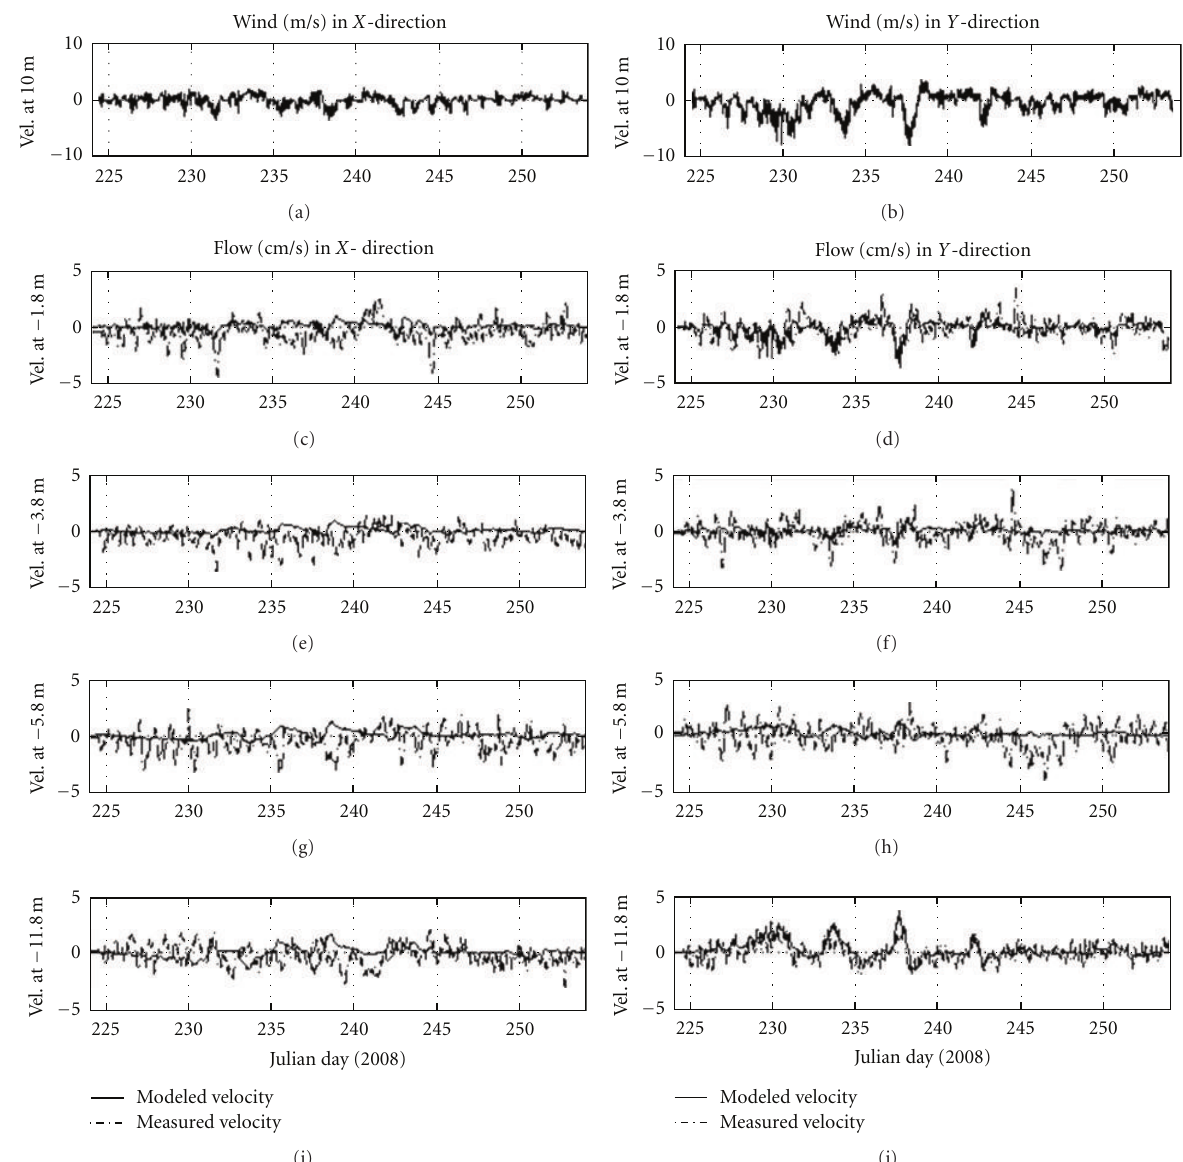
Figure 4: Comparison of the modeled and measured flow velocities at di ff erent water